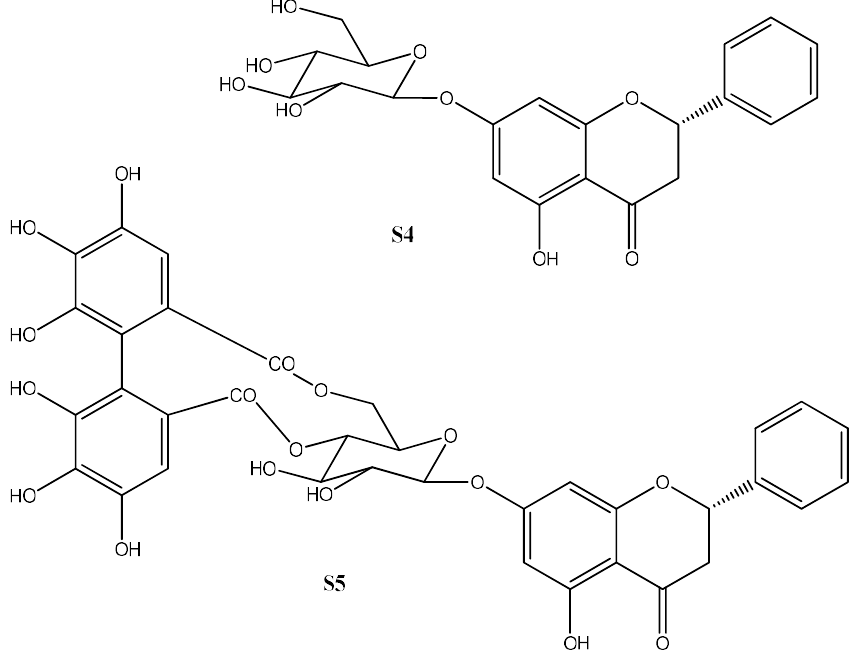
Figure 1. Chemical structure of isolated compounds, S4 and S5 . Table 1. Constituents (%) identified in the essential oils of the leaf, primary and secondary branches of Miconia minutiflora